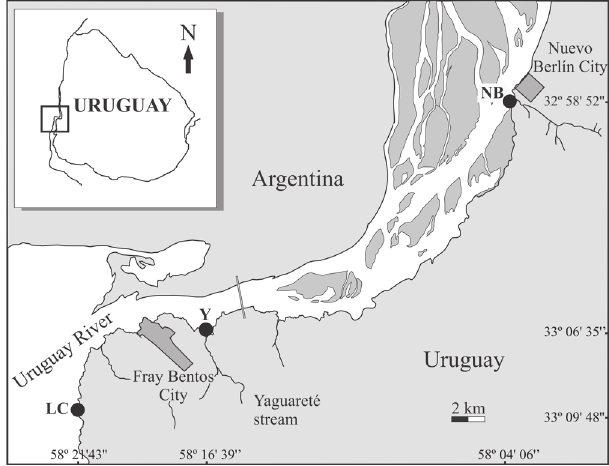
Fig. 1. Map of the study area. Samples sites are located on the Uruguay River: LC: Las Cañas, NB: Nuevo Berlín and Y: